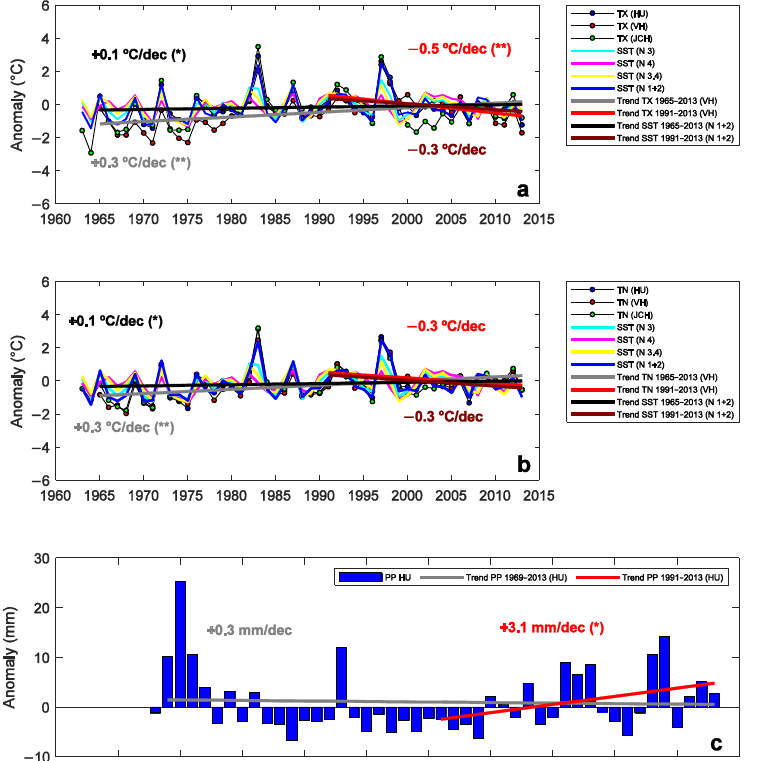
Figure 5. Linear trends for annual series of ( a ) maximum temperature (TX) and Niño 1+2 SST index, ( b ) minimum temperature (TN) and Niño 1+2 SST index and ( c ) precipitation (PP). Hipólito Unanue (HU), Von Humboldt (VH), and Jorge Chavez (JCH) stations. Niño SST indices corresponding to the regions Niño 1+2 (N1+2), Niño 3 (N3), Niño 3.4 (N3.4), and Niño 4 (N4). ** Statistically significant